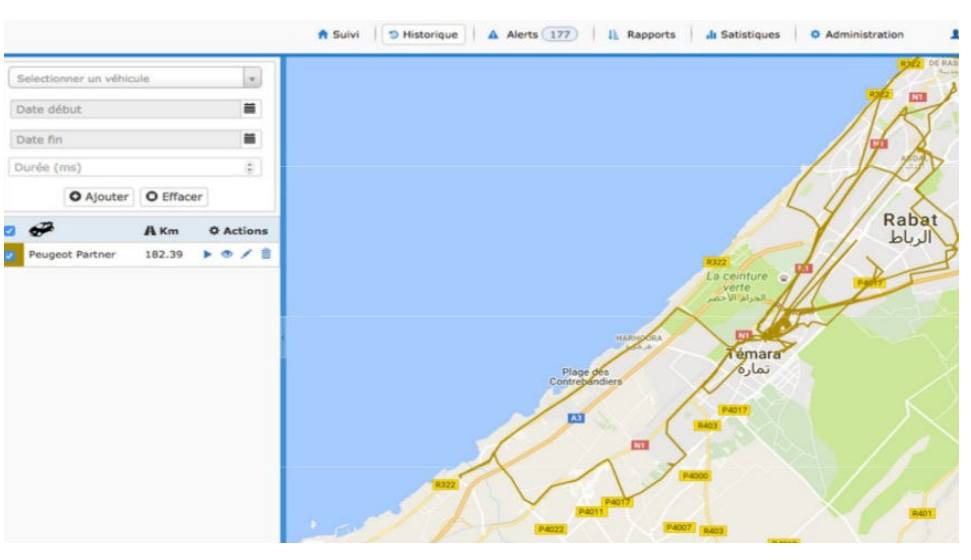
Figure 8. Vehicle trajectory